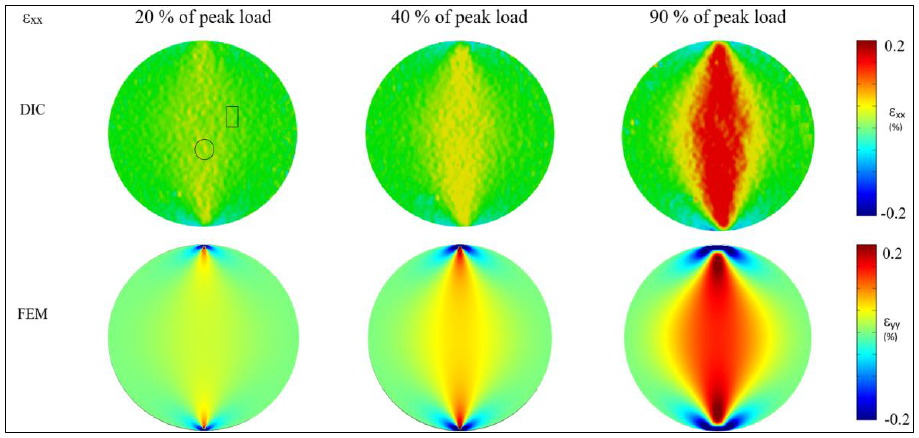
Figure 8. Horizontal strain ( ε xx ) distribution: DIC vs. simulation results.